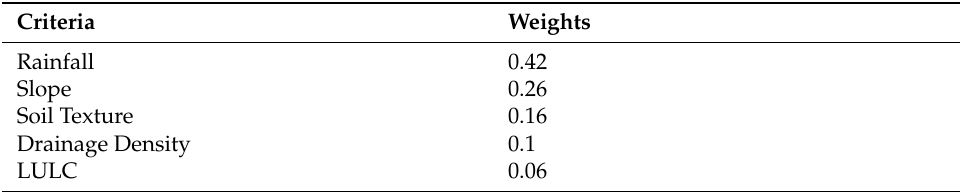
Table 7. Computed weights of criteria using the AHP